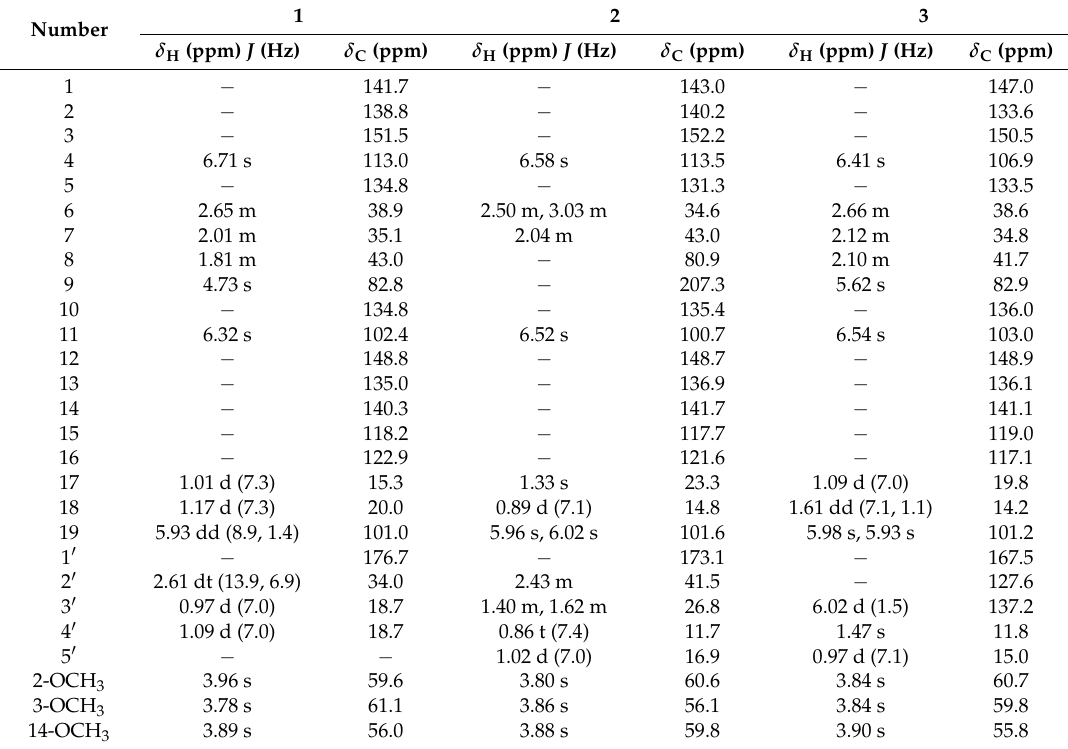
Table 1. 1 H- (600 MHz) and 13 C-NMR (150 MHz) data of compounds 1 , 2 , and 3 (CDCl 3 Figure 2. Key HMBC and NOESY correlations of heilaohulignan A ( 1 ) and ROESY correlations of heilaohulignans B–C ( 2 – 3 ).